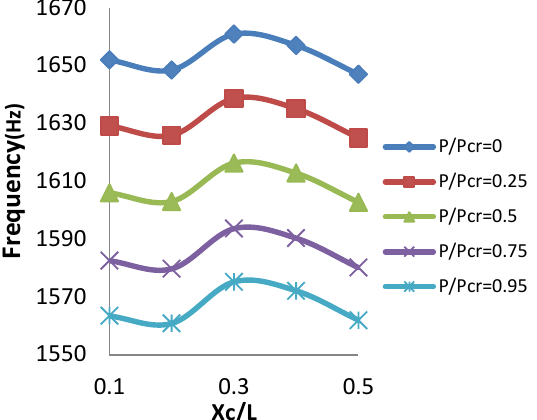
Fig. 6. Third frequency of cracked beam, subject to compressive load